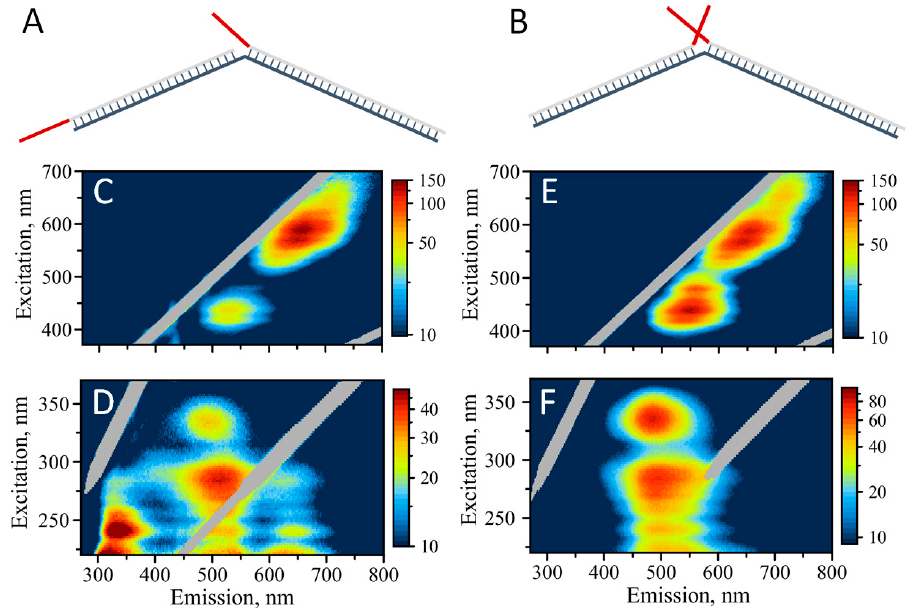
Figure 5. ( A ) Schematic representation of template design for the “forward” assembly, ( B ) schematic representation of template design for the “reverse” assembly. Templating C 12 sequences are shown in red. Excitation / emission maps of silver nanoclusters: ( C ) AgNC templated on “forward” assembly with excitation in the visible spectral range, ( D ) AgNC templated on “forward” assembly with excitation in the UV, ( E ) AgNC templated on “reverse” assembly with excitation in the visible spectral range, ( F ) AgNC templated on “reverse” assembly with excitation in the